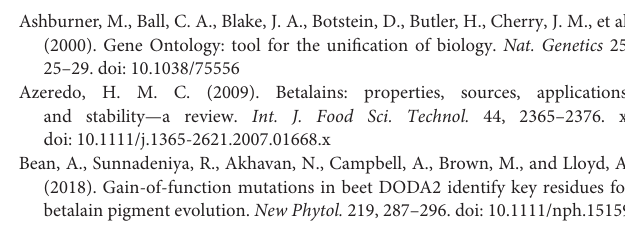
Supplementary Figure 1 | Stenocereus queretaroensis (pitaya) cactus. (A) Whole pitaya plant. (B) pitaya fruit. Supplementary Figure 2 | Culture cycle of pitaya suspension cells. (A) Color index from the Society of Dyes and Colorants. (B) Erlenmeyer flasks with pitaya suspension cells with different betalain content. Supplementary Figure 3 | Error rate distribution along with the six Libraries. (A) SqY1 (B) SqY2 (C) SqY3 (D) SqR1 (E) SqR1 (F) SqR1. Supplementary Figure 4 | Read quality distribution. (A) SqY1 (B) SqY2 (C) SqY3 (D) SqR1 (E) SqR1 (F) SqR1. Supplementary Figure 5 | Nitrogenated bases content. (A) SqY1 (B) SqY2 (C) SqY3 (D) SqR1 (E) SqR1 (F) SqR1. Supplementary Figure 6 | Sequence annotation analysis. (A) Sequence annotation in seven databases. (B) Venn diagram of gene distribution along with databases. (C) Species classification. (D) Similarity distribution. Supplementary Figure 7 | Gene functional annotation. (A) E-VALUE distribution. (B) KOG function classification. (C) KEGG classification. (D) GO function classification. Supplementary Figure 8 | Gene expression level, SqYC vs SqRT. (A) Pearson correlation. (B) FPKM density distribution. (C) FPKM distribution in boxplot. Supplementary Figure 9 | Differential expression analysis in SqYC vs SqRT. (A) Erlenmeyer flask with yellow and red cells. (B) Volcano plot of DEG. (C) Venn diagram of DEG. (D) . Heat map cluster analysis. Supplementary Figure 10 | Gene enrichment analysis. (A) Enrichment GO terms, up and down. (B) KEGG pathway enrichment, up-regulated genes. (C) KEGG pathway enrichment, down-regulated genes. Supplementary Figure 11 | In cell fluorescent detection of Stenocereus queretaroensis . PEG vs Sucrose 8%. (A) and (D) Bright field of culture cells. (B) and (E) . 355nM channel signal (DAPI). (C) and (F) Auto florescent Stenocereus queretaroensis culture cells at 488nM. Supplementary Table 1 | Total read and reads mapped. Supplementary Table 2 | Representative differential expressed genes in aromatic amino acid and betalain